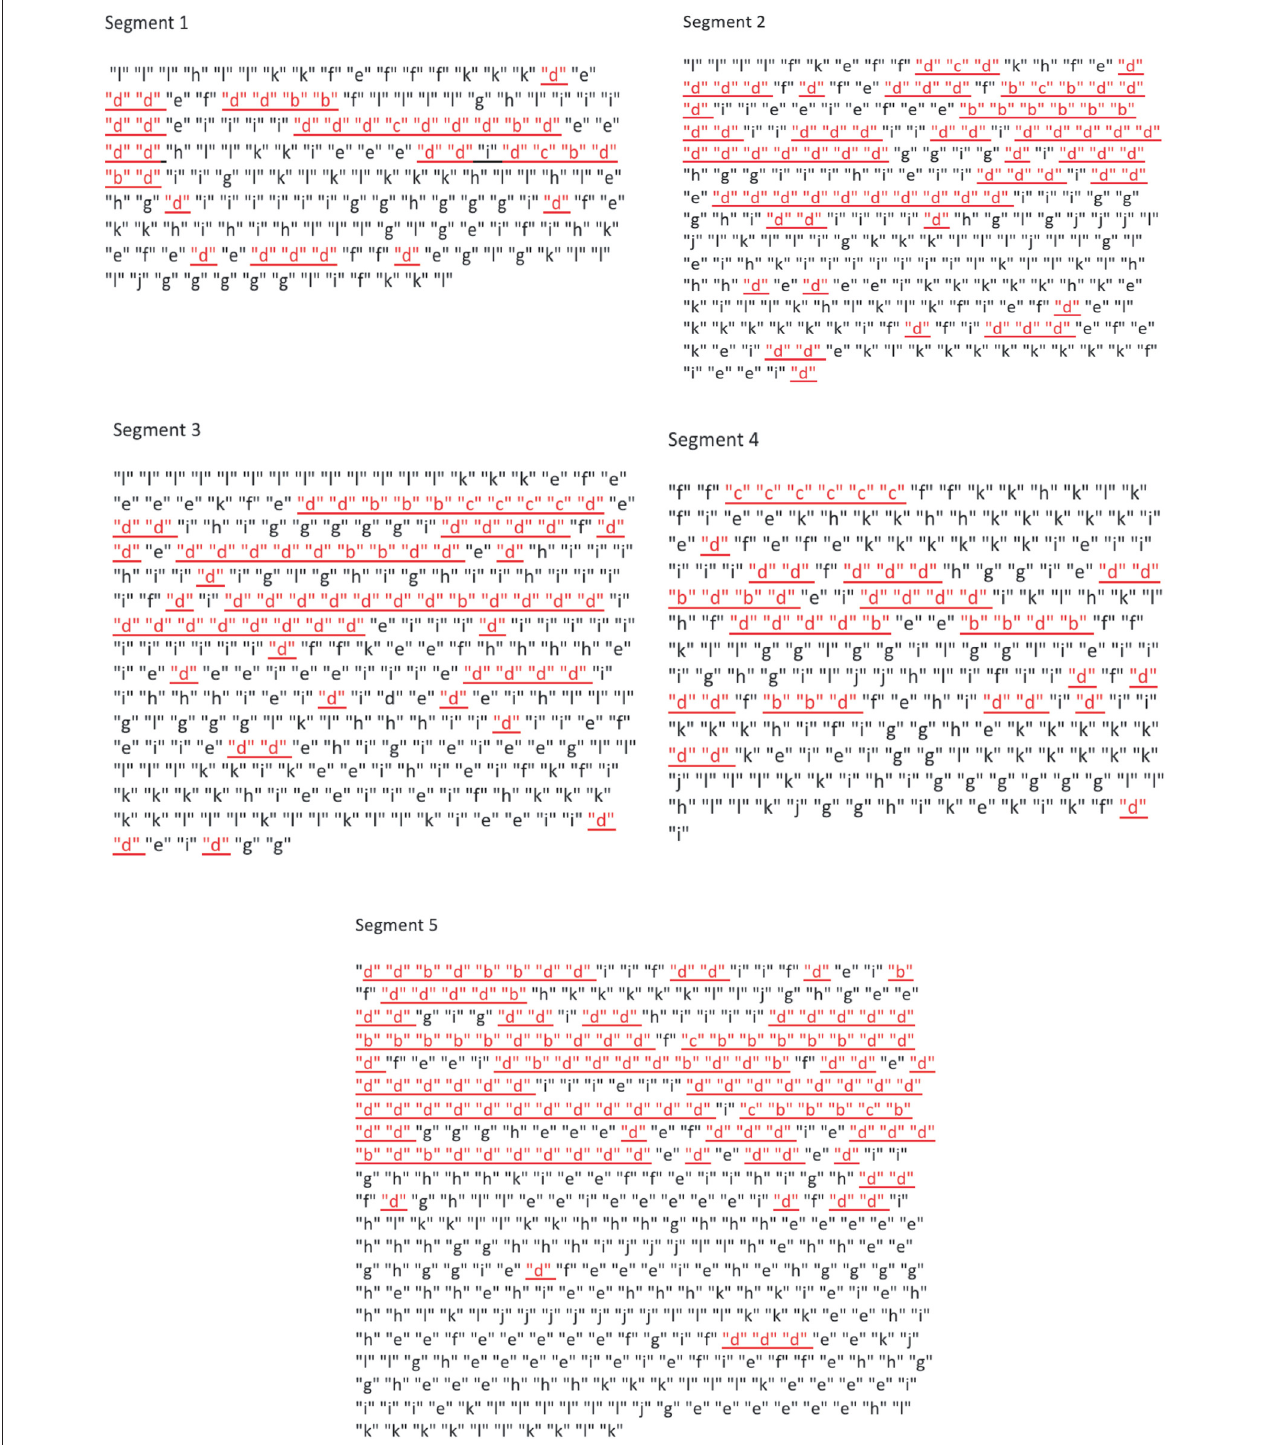
FIGURE 6 | Pattern-mechanics: seizure-bearing patterns through global system state trajectory within each five inter-ictal periods. Red color-coded and underlined global system states for inhibition and black color-coded global system states for excitations.